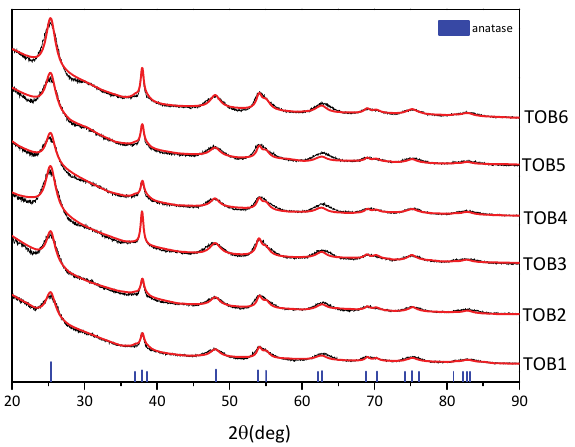
:(B) samples. Experimental data ( black curves ); Rietveld Figure 2. XRD patterns of TiO 2 fitted profiles ( red curves ); anatase peaks positions ( blue )